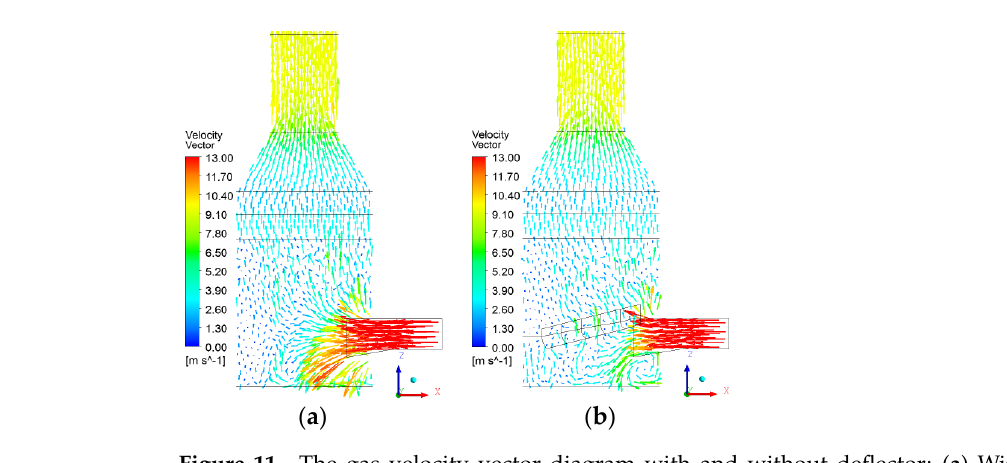
Figure 11. The gas velocity vector diagram with and without deflector; ( a ) Without deflector; ( b ) With deflector.